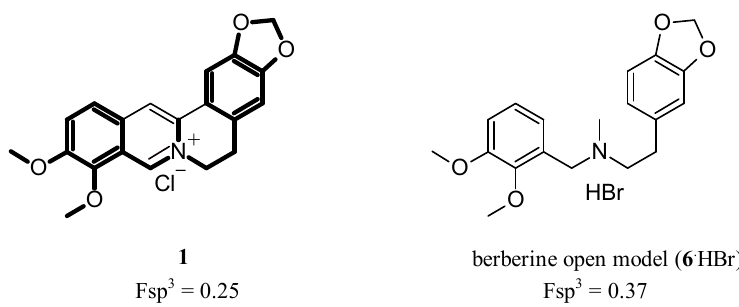
Figure 2. Structures of both berberine ( 1 ) and its open model ( 6 . HBr).